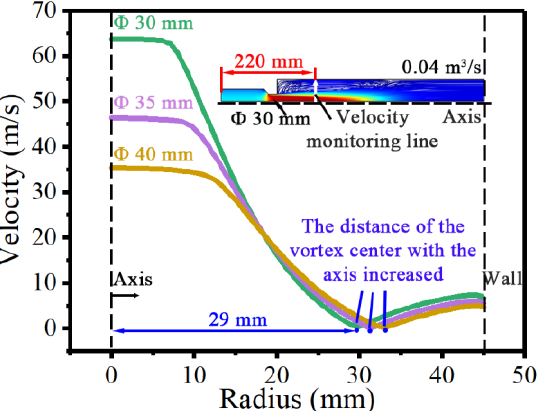
Figure 9. Effect of the diameter of the ball seat on the flow velocity; the fluid viscosity was set as 100 mPa·s.